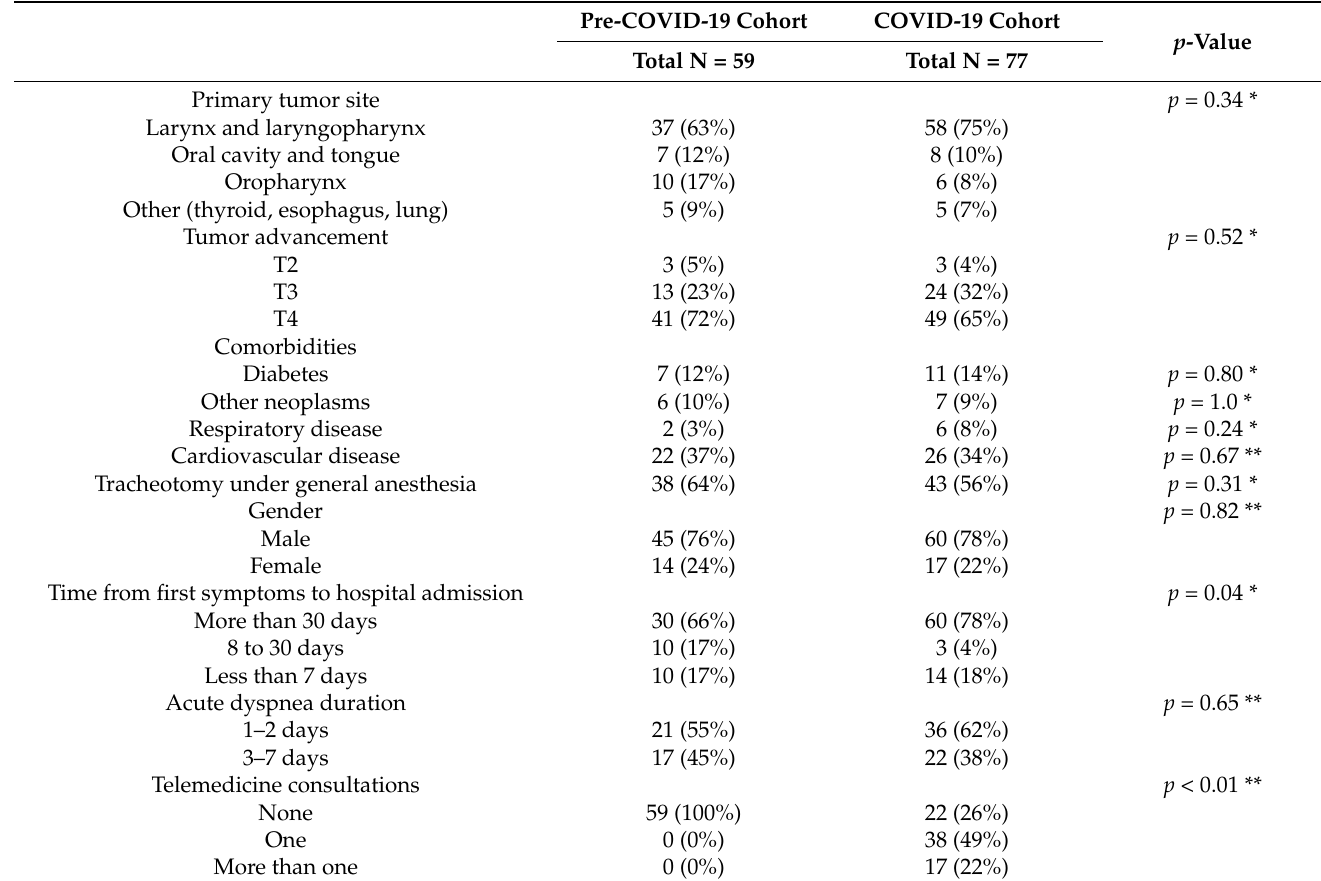
Table 2. Patients who developed dyspnea due to advanced head and neck cancer were treated with an open surgical tracheotomy in two-time cohorts: pre-COVID-19 and COVID-19. Pre-COVID-19 Cohort COVID-19 Cohort Total N = 59 Total N = 77